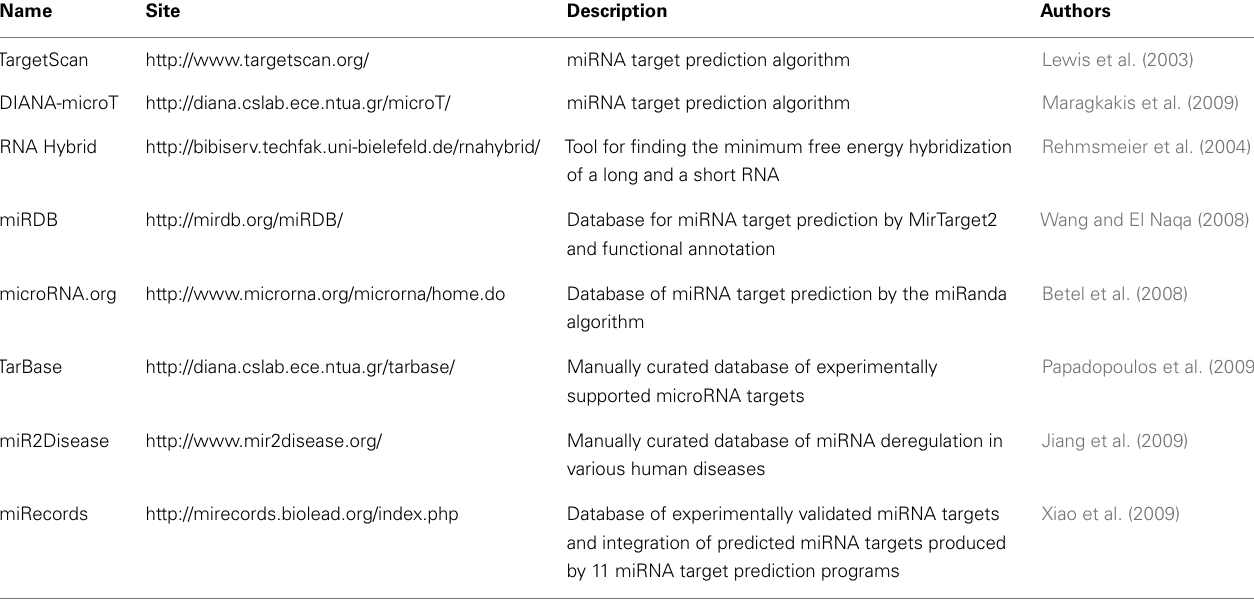
Table 8 | miRNA target prediction tools and databases.